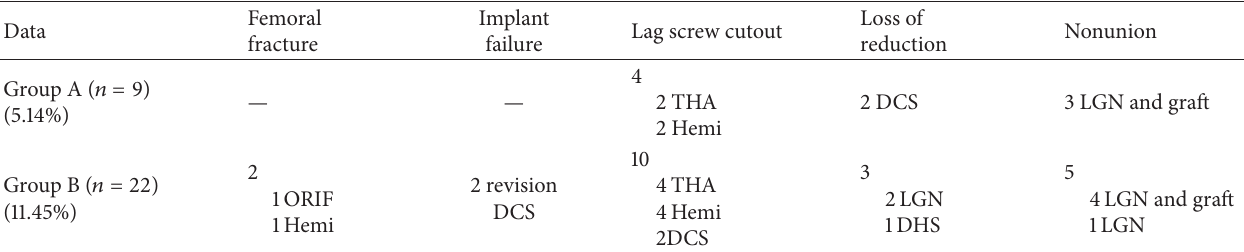
Table 4: Reoperation